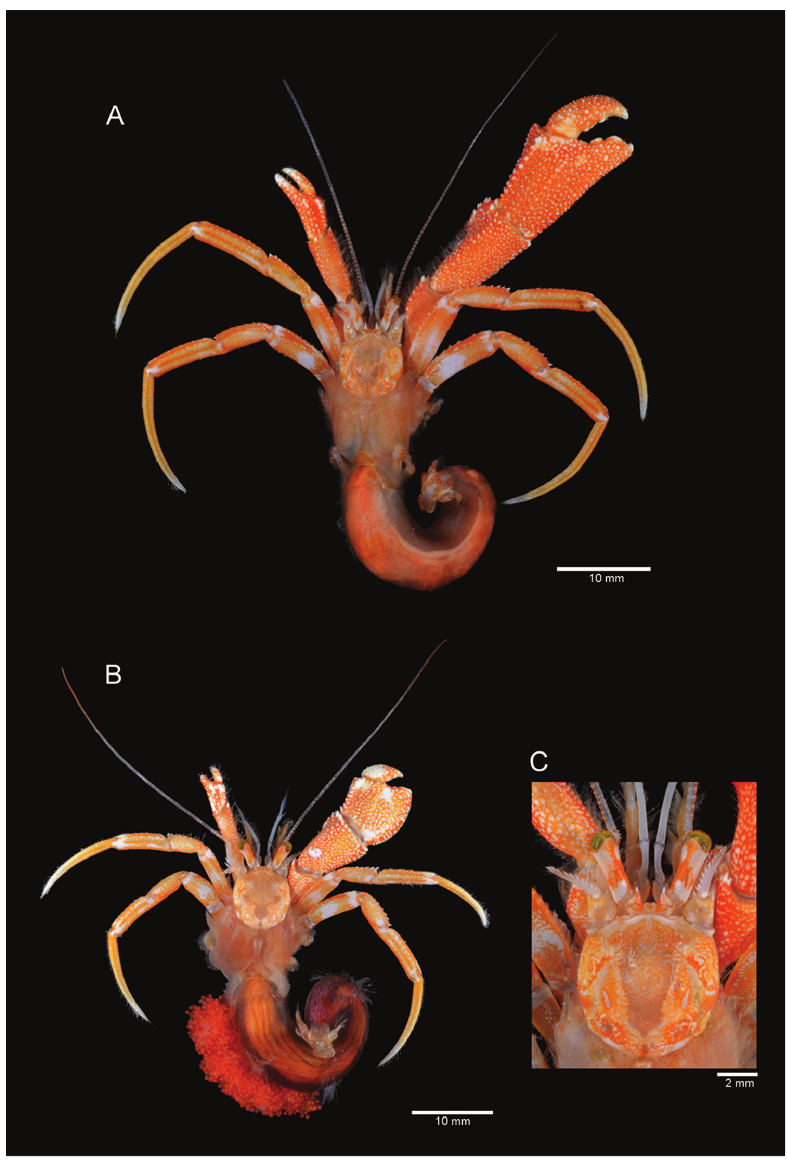
Figure 6. Colouration (in life or fresh). Paragiopagurus atkinsonae sp. n., South Africa, West Coast: A male holotype 7.0 mm, WCDSS2016 (USNM 1292083) B ovig. female 6.4 mm, WCDSS2016 (SAMC MB-A066816) C ovig. female 6.8 mm, WCDSS2016 (SAMC MB-A066809), shield and ce- phalic appendages, dorsal